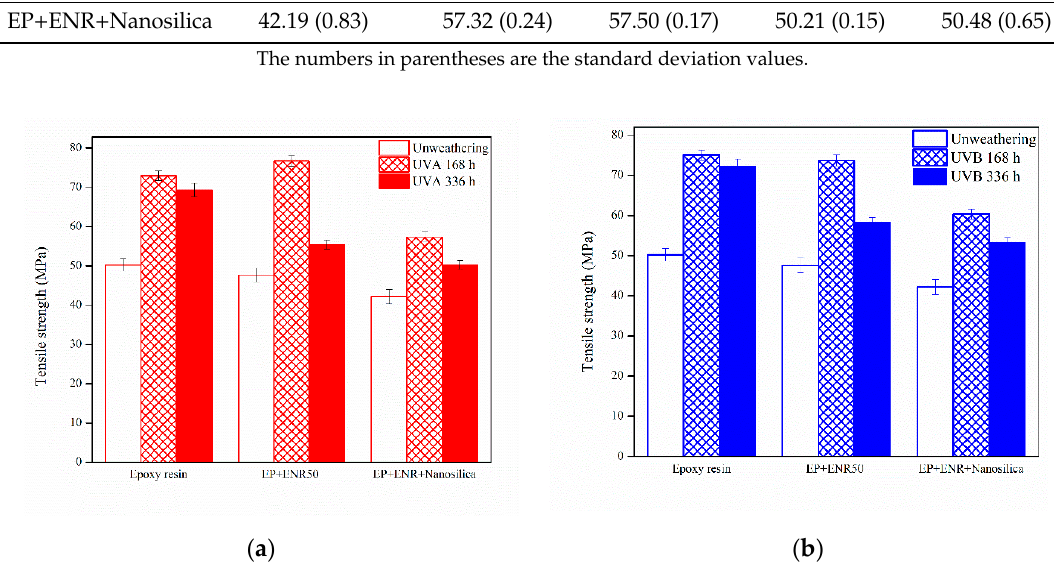
Figure 2. Tensile strength of nanocomposites after accelerated aging ( a ) UVA and ( b ) UVB.